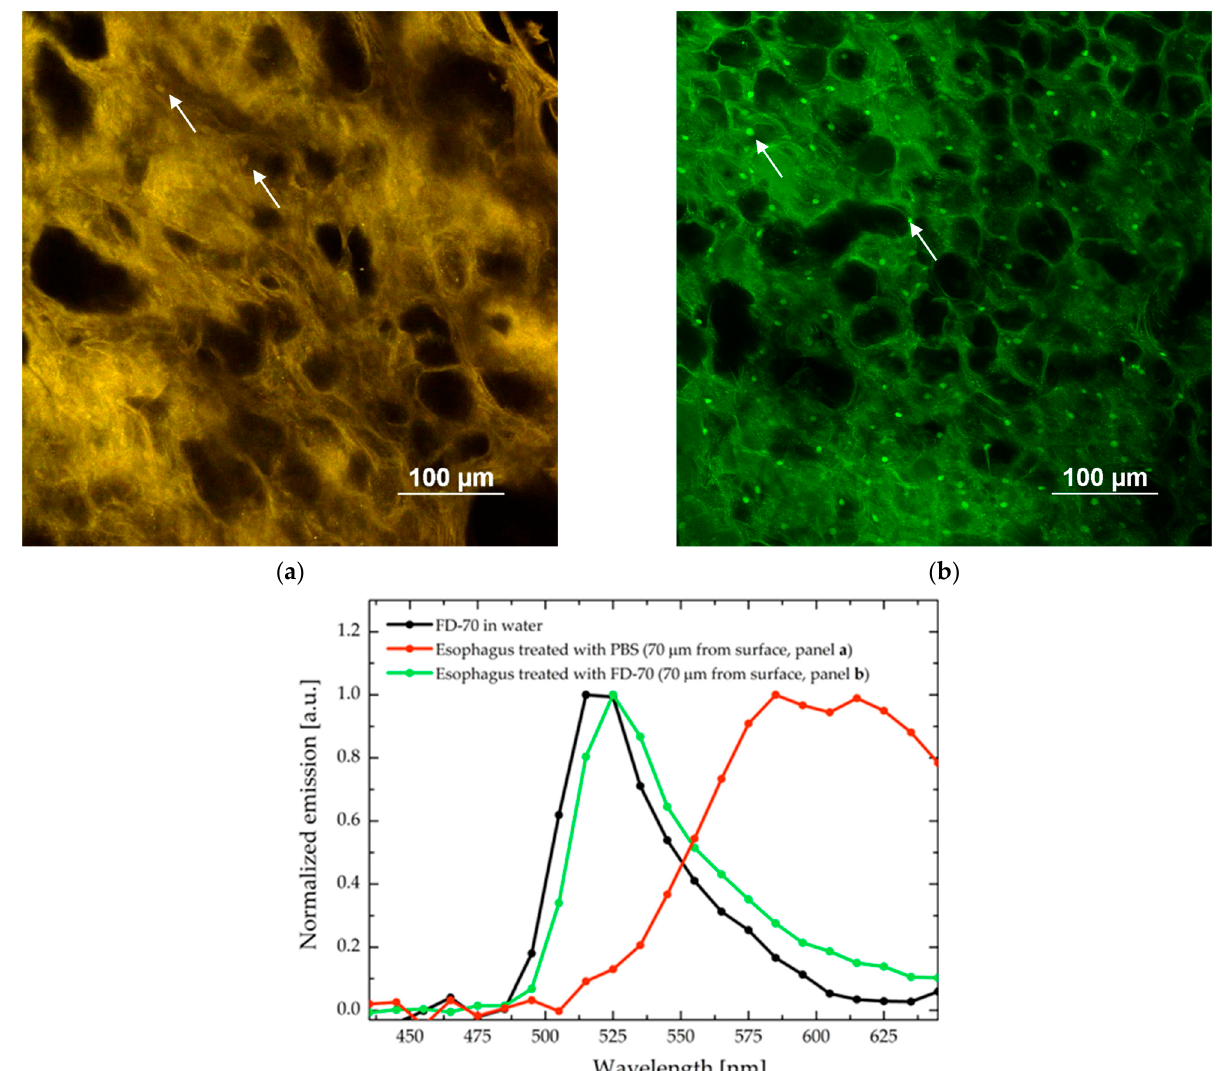
Figure 5. ( a , b ): TPEF images (image size: 500 × 500 µm) acquired at an intermediate depth (~70 µm from the surface) with an excitation wavelength of 1030 nm from the blank and treated with caprylic acid (C8) tissues, respectively; ( c ) comparison between the normalized emission spectra of an FD-70 aqueous solution and the blank and treated tissues (excited at 1030 nm and recorded in correspondence with the ( a , b ) focal plane). Arrows in panels a and b display epithelial cell nuclei.